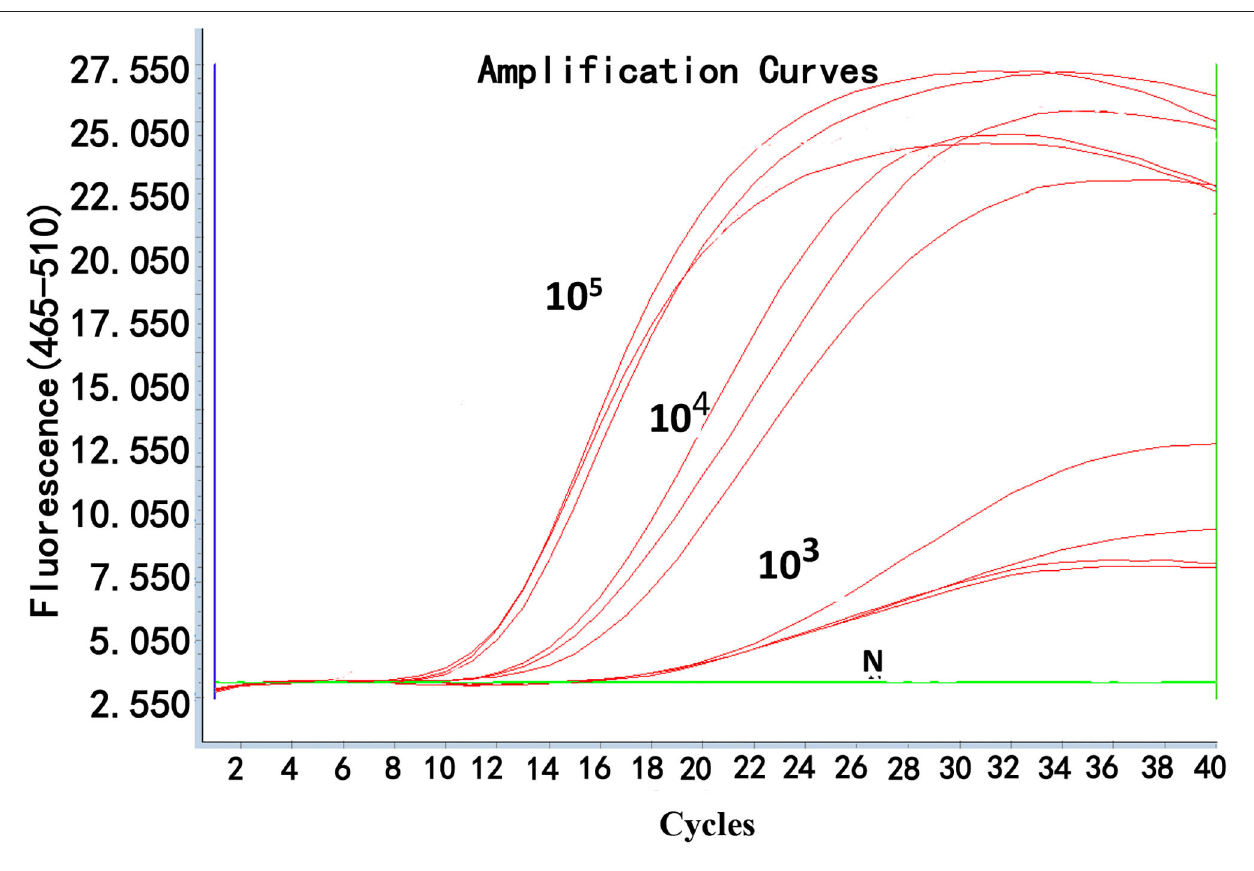
FIGURE 4 | Reproducibility of real-time RPA.